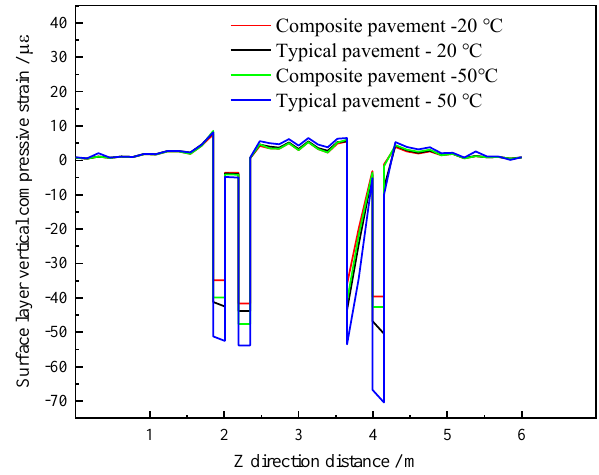
Figure 19. Vertical compressive strain of the surface layer.